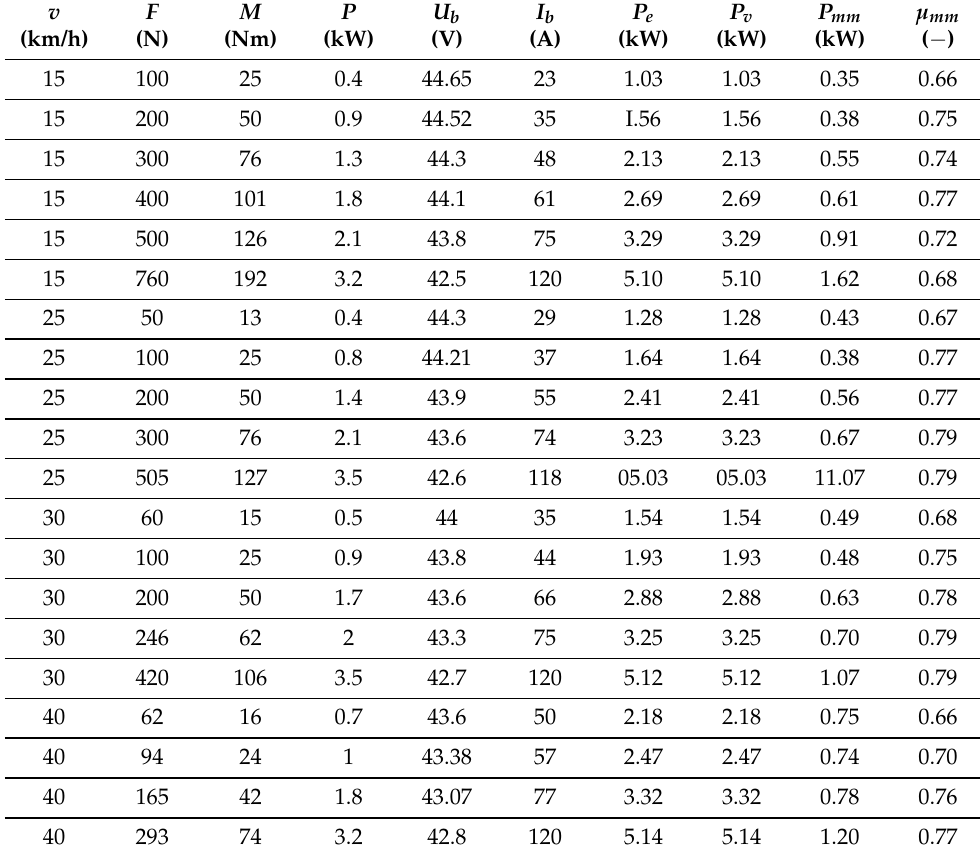
Table 2. Motor and converter loss measurement results.